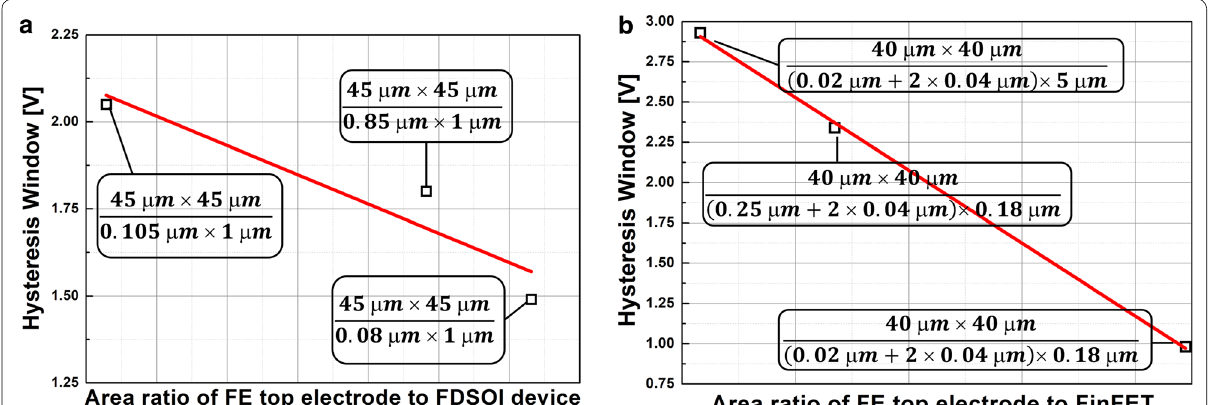
Fig. 8 Measured hysteresis window of a FE-FDSOI, b FE-FinFET vs. the area ratio of ferroelectric capacitor top electrode to baseline FET